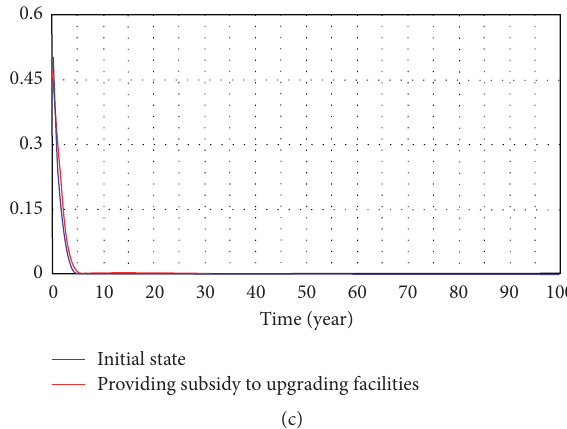
Figure 3: Simulation results by government providing subsidy incentives. (a) Probability of the enterprise upgrading facilities. (b) Probability of the government’s regular inspection. (c) Probability of the residents appealing to compensation.